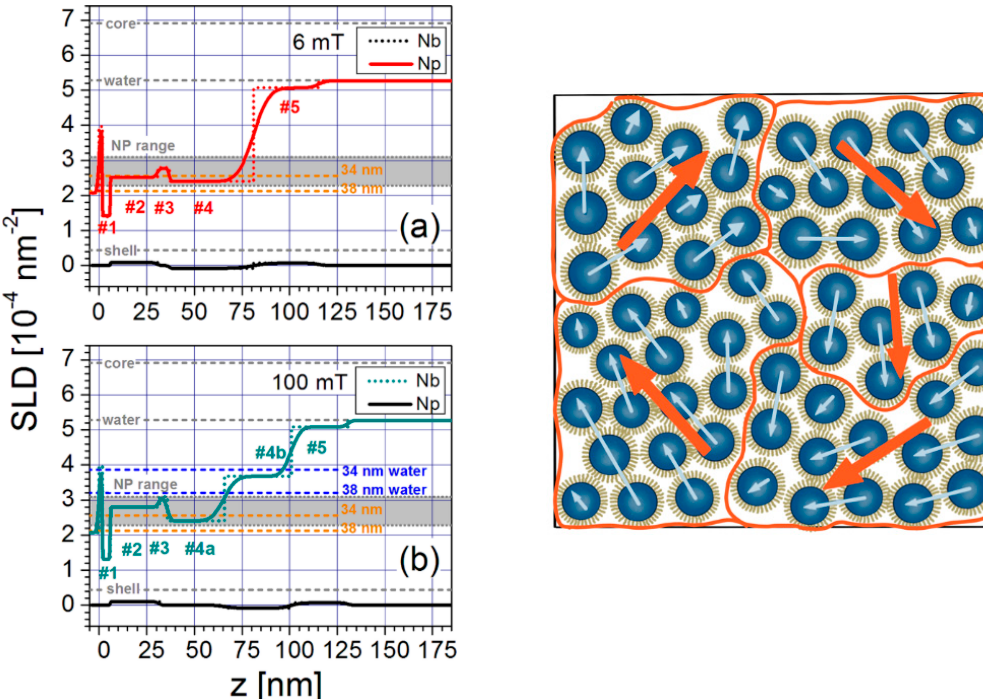
Figure 23. Left: Profiles of nuclear (Nb) and magnetic (Np) scattering length density (SLD) plotted as a function of distance z from the silicon surface determined from fits to polarized neutron reflectometry (PNR) data taken at 6 mT ( a ) and 100 mT ( b ). For comparison, SLD values for the magnetite core, water, and shell material are included as gray dashed lines. The SLD range between the compressed and stretched ligand model for isolated NPs is shown as a gray area. Model SLD values for a close-packed layer of truncated particles with shell material in the intershell gaps (orange dashed lines) and with water in the intershell gaps (blue dashed lines) are given for core / shell NP diameters of 34 and 38 nm, respectively. Right: Sketch of a possible magnetic moment distribution within an NP layer when the NPs experience a quasi-domain configuration. The solid orange outlines represent the domain walls. (Reprinted with permission from [186]. Copyright 2018 American Chemical